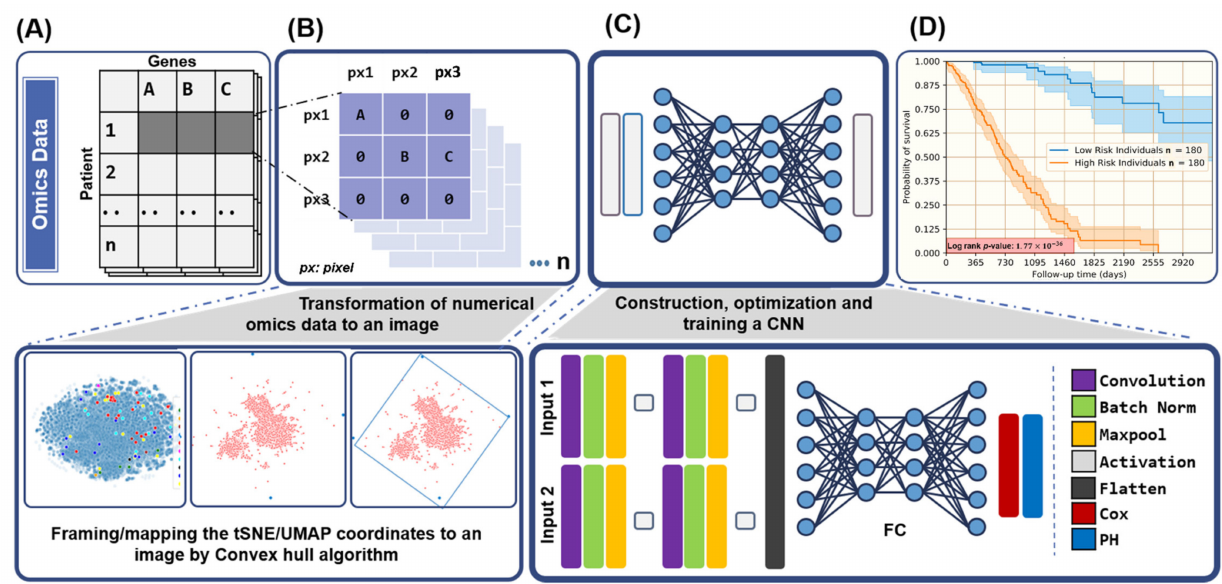
Figure 1. Schematic depicting the general workflow for SurvCNN. ( A ) Multi-omics data retrieval, ( B ) feature transformation, ( C ) building, training, and optimizing a deep neural network and ( D ) downstream analysis and